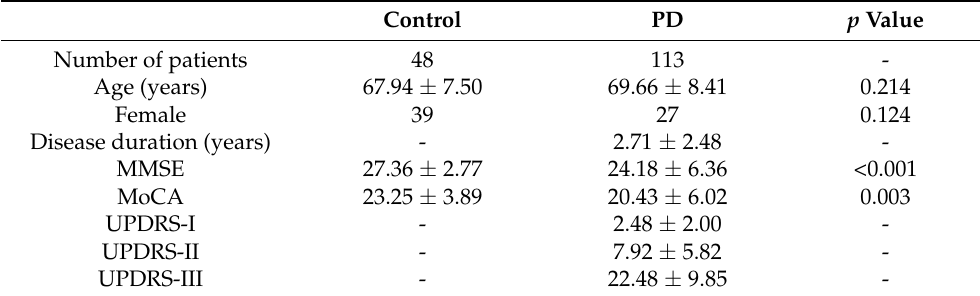
Table 1. Demographic data in Parkinson’s disease (PD) patients and control group.